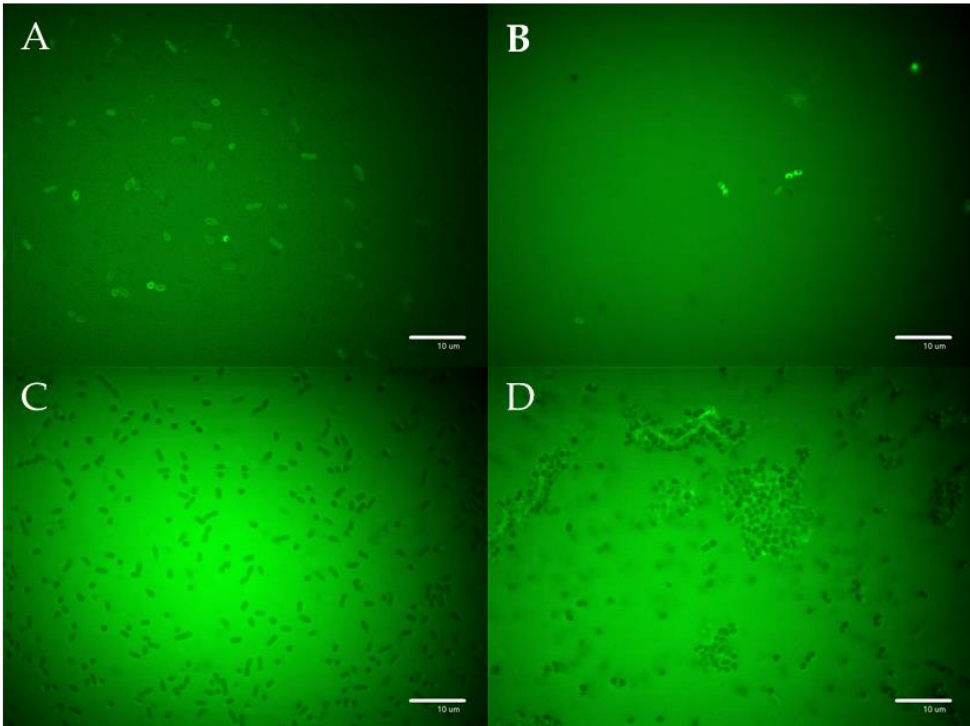
Figure 5. Images of bacterial cells observed using fluorescence microscopy. E. coli incubated with ( A ) F-PEP ( B ) F-P-PEP , and ( C ) F-P . Fluorescently-labeled PEP and polymer construct F-P-PEP but not the F-P polymer showed significant accumulation on the bacterial cell walls. ( D ) F-P-PEP interacted with S. aureus extracellular structures.